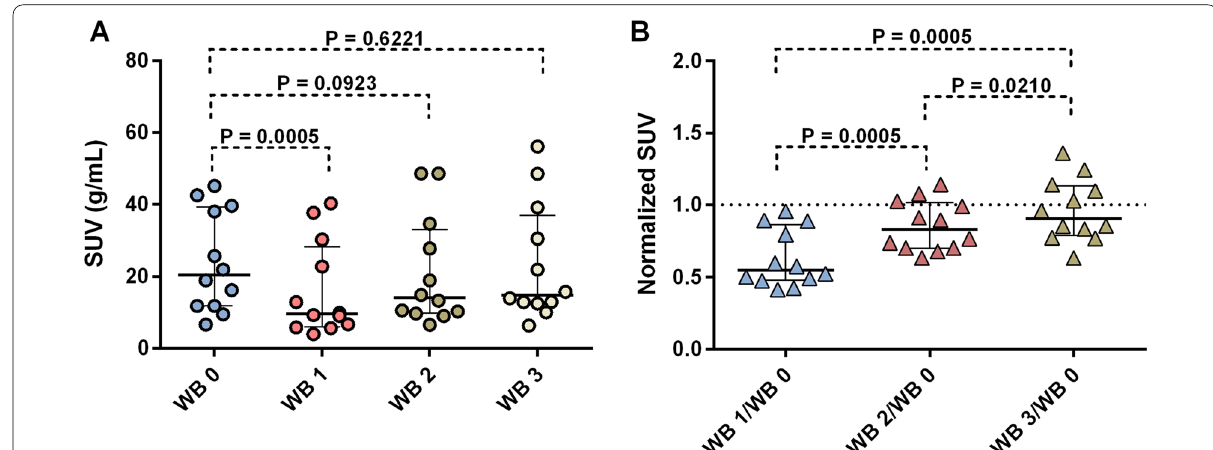
Fig. 3 Scatter dot plots for ( A ) mean tumor SUV at baseline (WB 0), WB 1 (0 h), WB 2 (4 h) and WB 3 (7 h) and ( B ) normalized SUV, whereby the tumor SUV at WB 1, 2 and 3 is normalized against tumor SUV at WB 0 (SUV ratio). The solid line represents median and interquartile range and the dotted line ( B ) normalized SUV value of 1. Significant decrease ( P < 0.05) was found in tumor SUV between WB 0 and WB 1, however, not between WB 0 and WB2 and WB 0 and WB 3 ( P > 0.05). Significant subsequent increase was found in normalized SUV between all three WB examinations (WB 1, 2 and 3) ( B ). Thus, the normalized SUV returned to baseline levels at 4 and 7 h